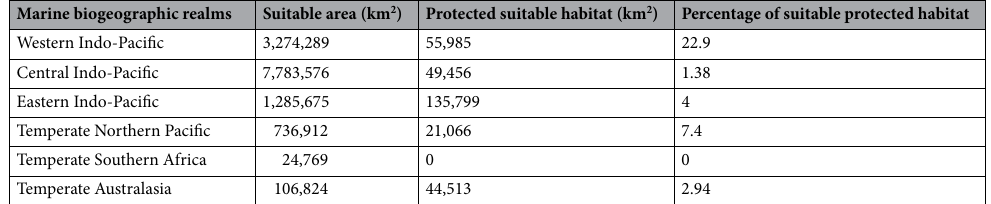
Table 2. Estimates of suitable habitats, protected suitable habitats and percentage of suitable protected habitats of the Metopograpsus thukuhar / cannicci species complex within the five marine biogeographic